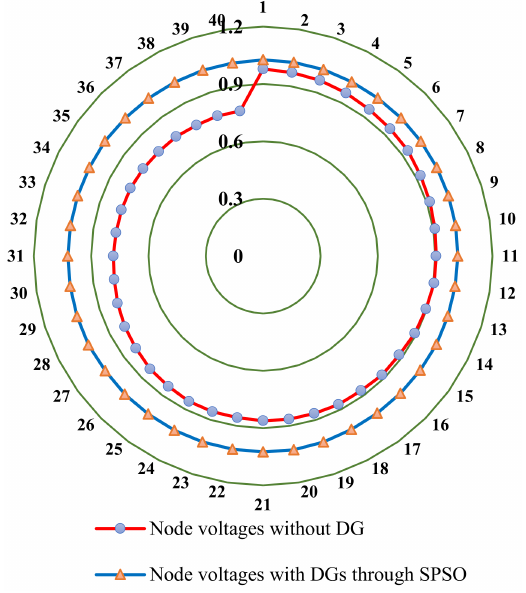
Figure 6. Improvement in node voltages with DGs. After running the algorithm, the optimal positions obtained for DG1 and DG2 are at bus numbers 17 and 30, respectively. The optimal sizes for DG1 and DG2 are 5802 kVA and 5232 kVA, respectively. Table 3 shows the objective function values obtained by these optimal positions and sizes of DGs after load flow analysis. With the effective implementation of DGs through the proposed SPSO, the voltages at all the nodes are now within the standard limits, and accumulative power loss is considerably reduced from 1175.935 kW to 92.444 kW. The supply from the main power grid is reduced due to the handling of excessive load by DG. Due to which less current flows in transmission lines, resulting in reduced active power loss and voltage drop. The optimal results are achieved when DGs are integrated at accurate